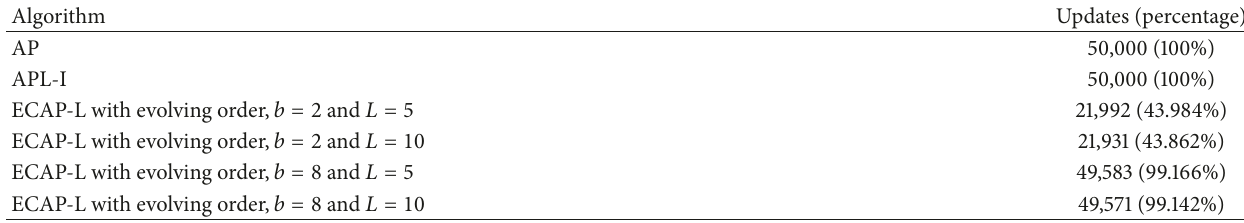
Table 3: Numbers of updates and update percentages for the single-channel ANC system.